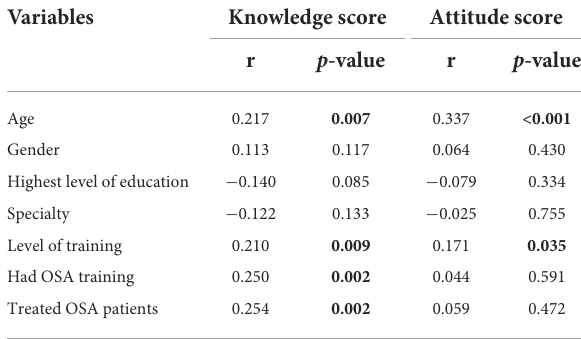
TABLE 4 Correlation analysis of the knowledge score and the attitude